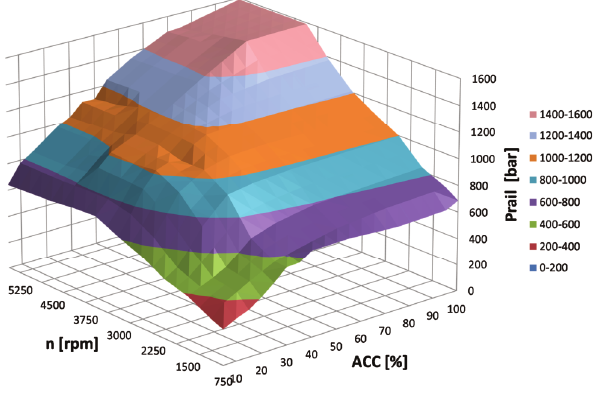
Fig. 8. Fuel pressure in the rail